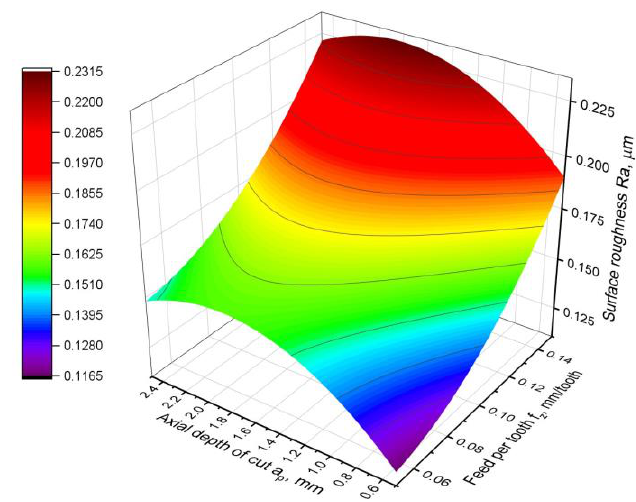
Figure 12. Surface roughness Ra parameter model. Table 7. Analysis of variance for the Ra surface roughness model.